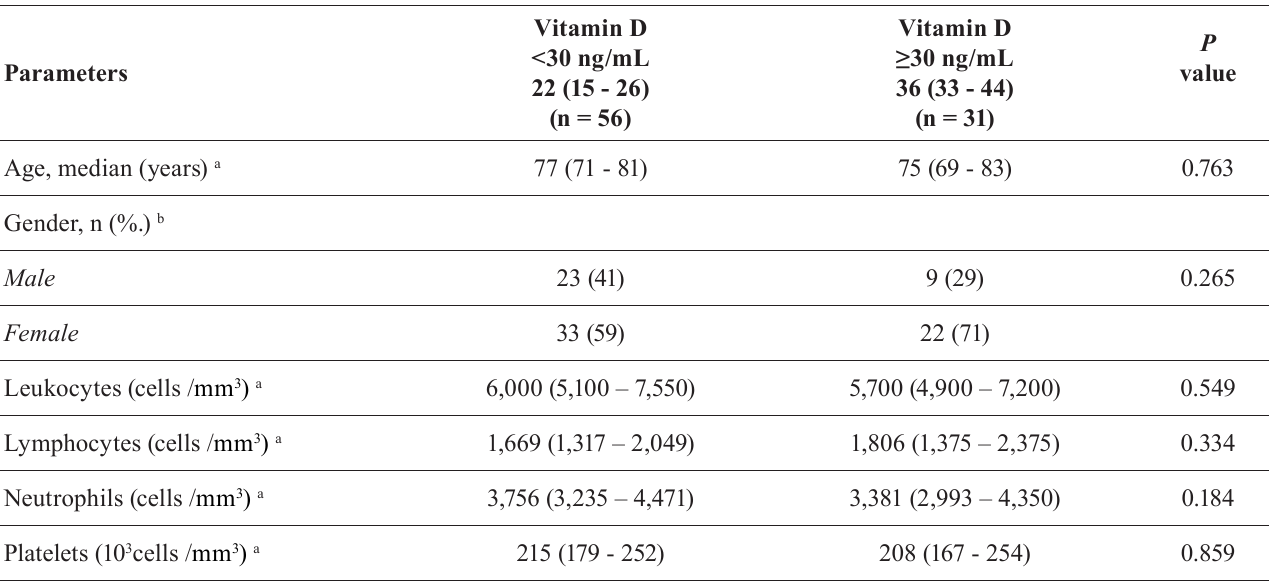
TABLE I - D emographic and laboratory data of the individuals, according to the groups formed according to the presence or absence of vitamin D deficiency